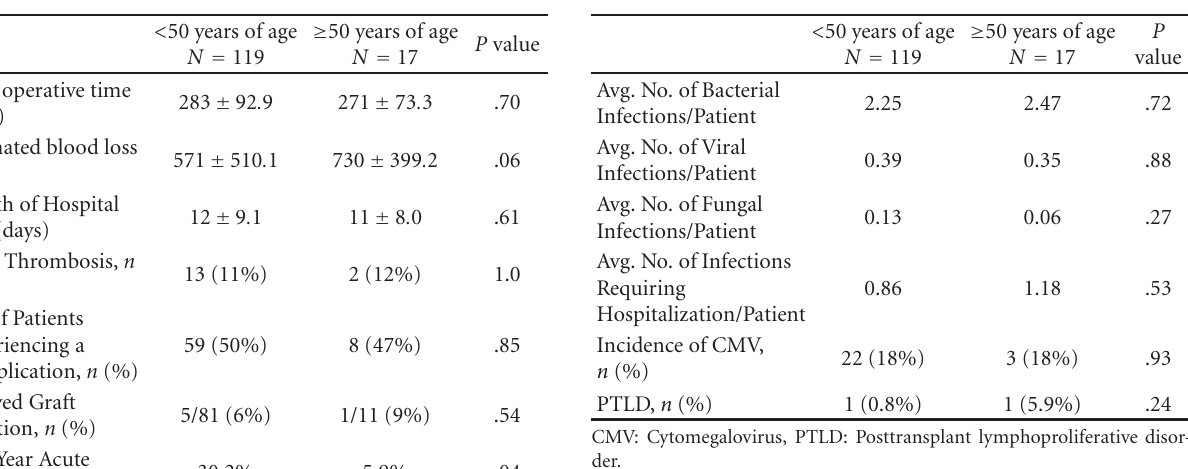
Table 2: Perioperative and postoperative parameters.